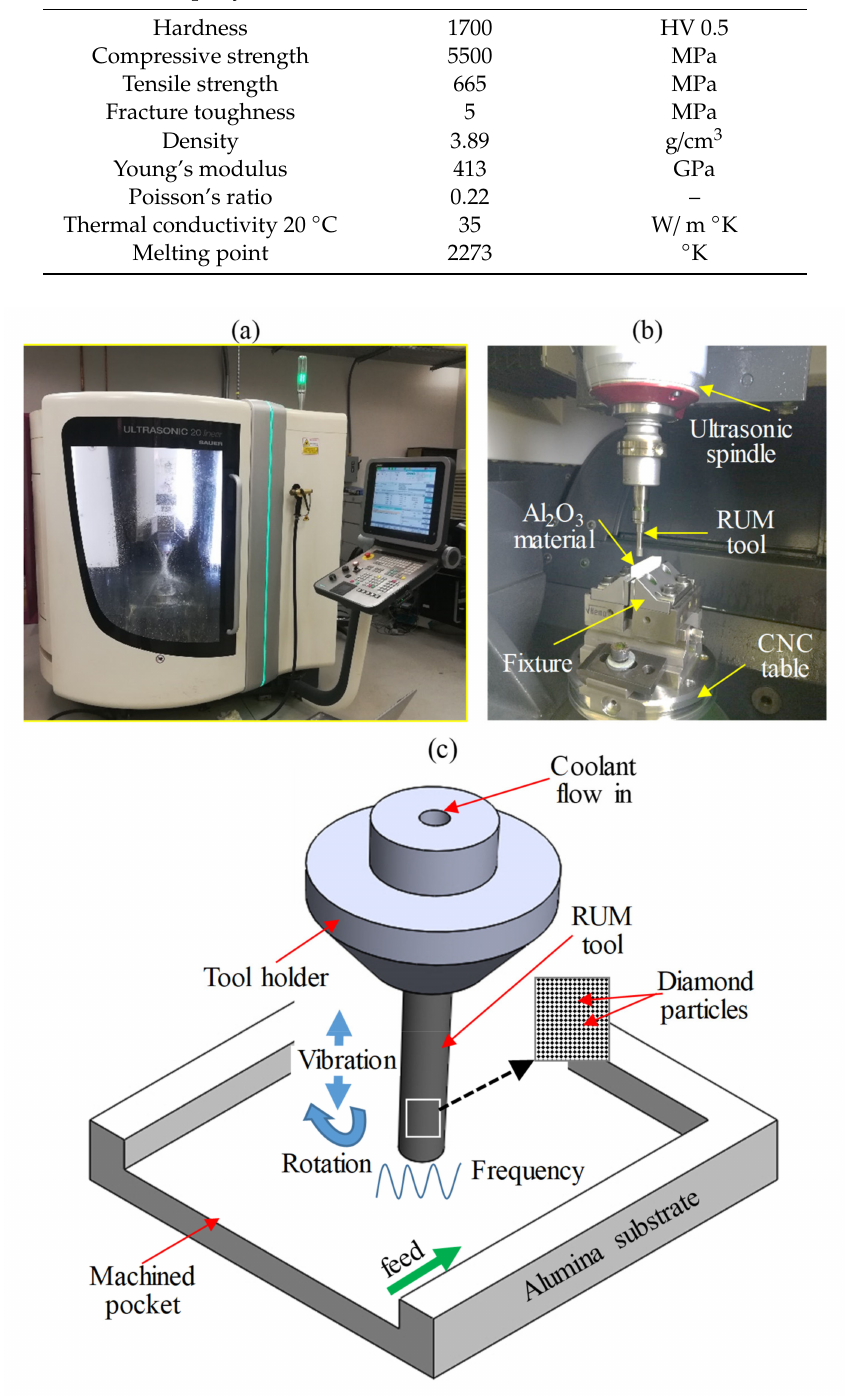
Figure 1. ( a ) RUM machine, ( b ) experimental set up, and ( c ) schematic of